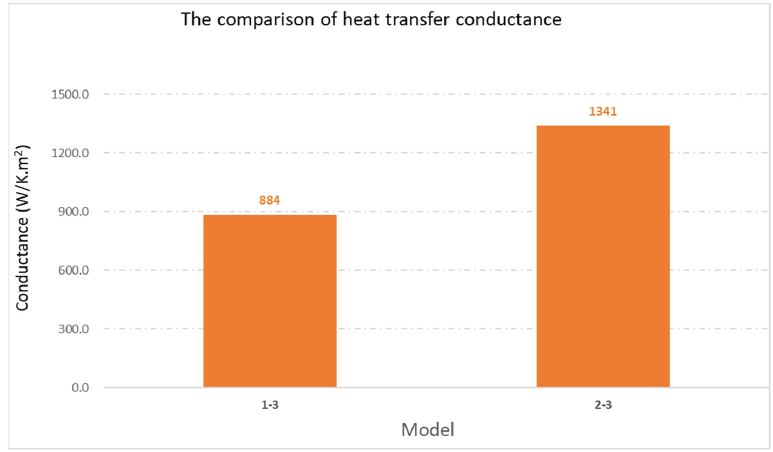
Figure 16. The comparison of heat transfer conductance between two cooling